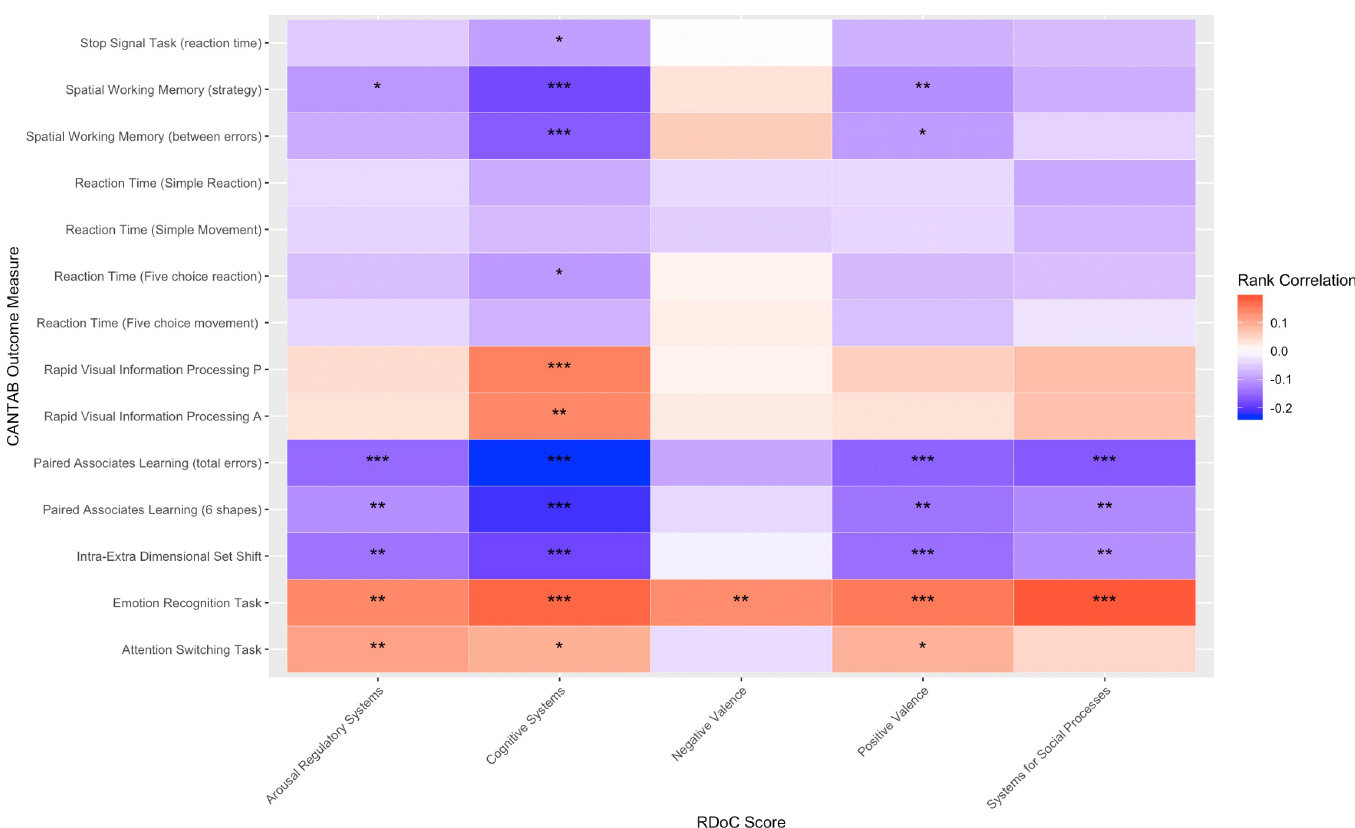
Fig 4. RDoC score rank correlation heatmap: We calculate the rank correlation between the selected CANTAB cognitive score metrics and embedding-based derived RDoC scores. High correlation is shown in warm colors. Significance is shown with stars: 0.1 � , 0.05 �� , and 0.01 ��� .